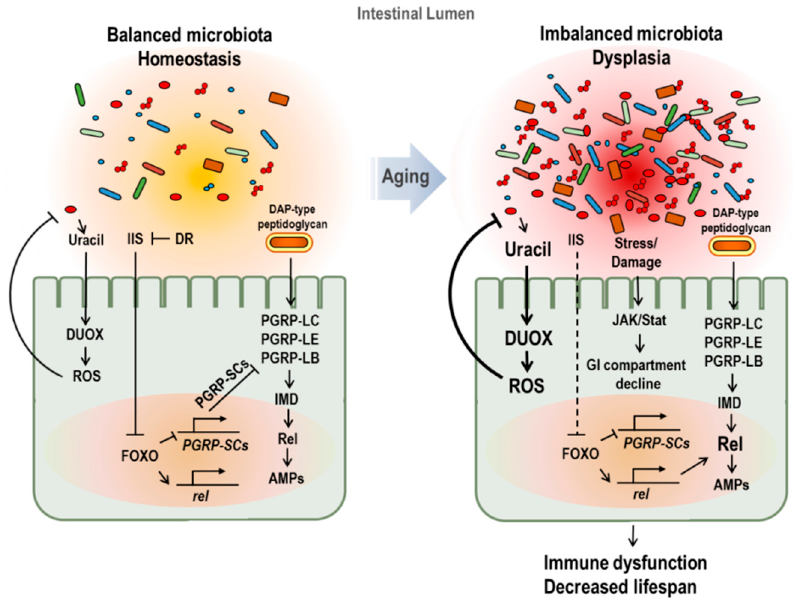
Figure 2. Age-dependent changes of gut microbiota and its effect on aging in Drosophila . In young flies ( left figure ), peptidoglycan recognition protein SC2 (PGRP-SC2) is active, facilitating the gut microbiota balance and immune homeostasis. In aged flies ( right figure ), imbalanced microbiota and dysplasia with increase in microbial loads are observed. Increased microbial load with age enriches peptidoglycans in lumen and causes a chronic inflammation. In addition, activated FOXO, caused by insulin resistance and stress accumulation, represses the PGRP-SC2 expression and enhances Relish and AMPs gene expression. Furthermore, imbalanced microbiota activates DUOX with the increase pathobionts-derived uracil. These changes induced by imbalanced microbiota in aged fly cause immune dysfunction and lifespan reduction.